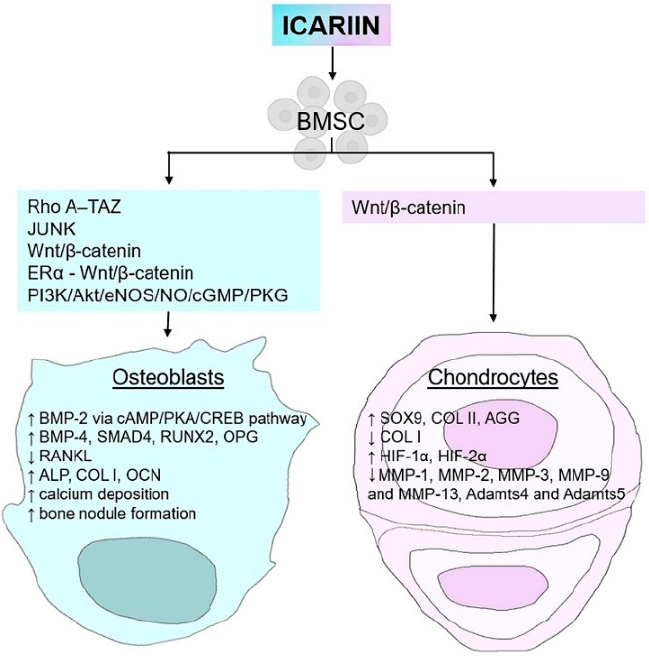
Figure 3. Icariin’s effect on bone marrow stem cells (BMSCs) as a promoter of bone formation and a potential accelerator of chondrogenesis via different signaling pathways. Icariin exerts an osteogenic effect by promoting the expression of osteoblastic specific genes, bone morphogenetic proteins (BMP-2, BMP-4), SMAD4, RUNX2, osteoprotegerin (OPG), alkaline phosphatase (ALP), collagen type I (COL I), osteocalcin (OCN) and the downregulation of the receptor activator of nuclear factor kappa-B ligand (RANKL). Icariin also upregulates calcium deposition and bone nodule formation. Its chondrogenic effect is due to the upregulated expression of SRY-Box transcription factor 9 (SOX9), collagen type II (COL II), aggrecan (AGG), and the downregulation of COL I. It also serves as an activator of hypoxia-inducible factors (HIF-1 α and HIF-2 α ) and several metalloproteinases (MMP) and a disintegrin and metalloproteinase with thrombospondin motifs (ADAMTS) in chon- drocytes.